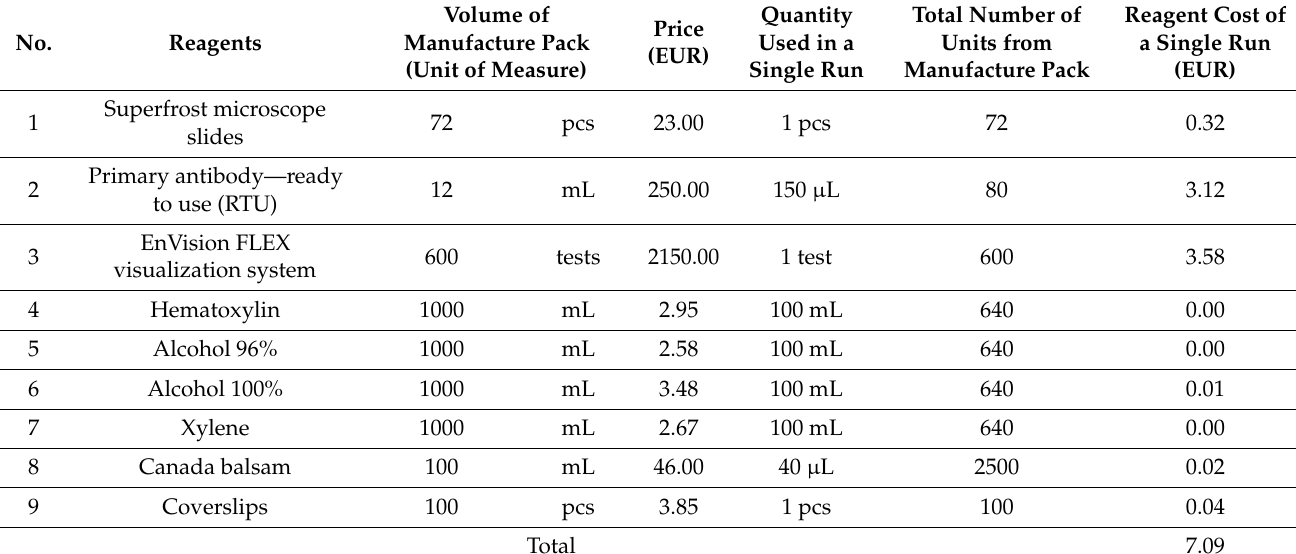
Table 3. Costs of reagents used for single immunohistochemistry run (one IHC microscope slide) in automated procedure.